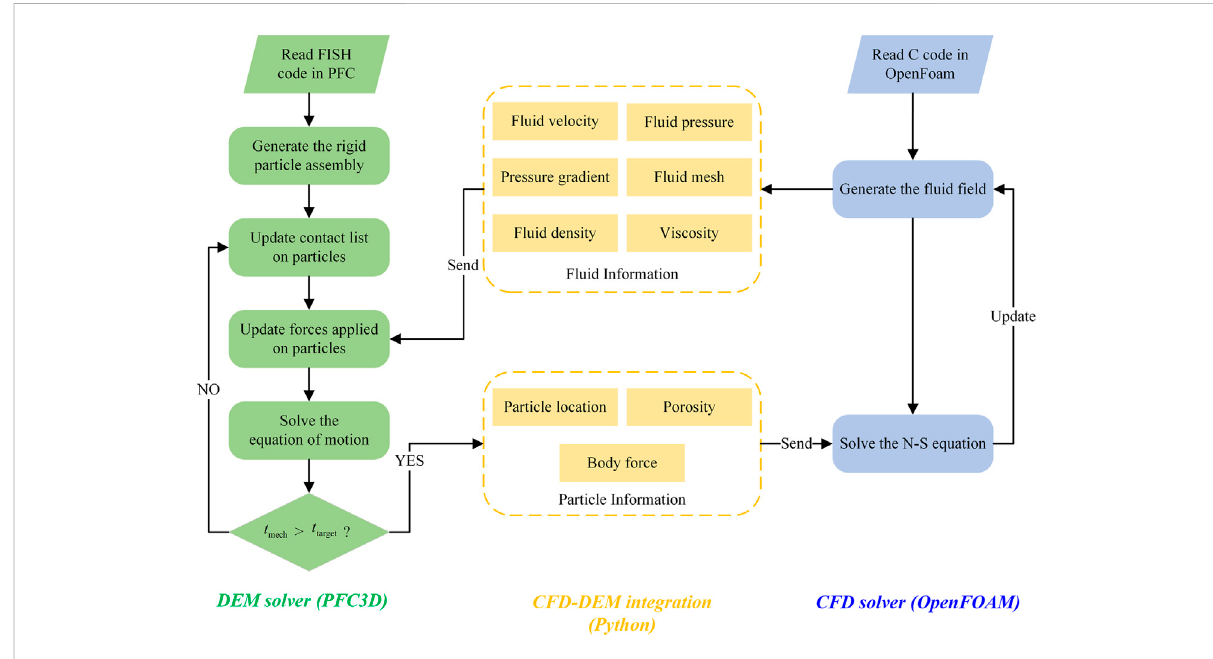
FIGURE 1 Coupling fl owchart of the CFD – DEM method.